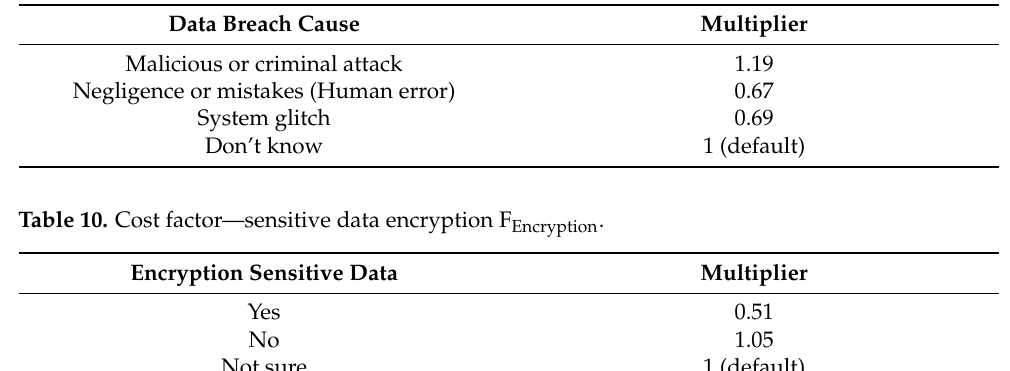
Table 9. Cost factor—data breach causes F breach_cause .